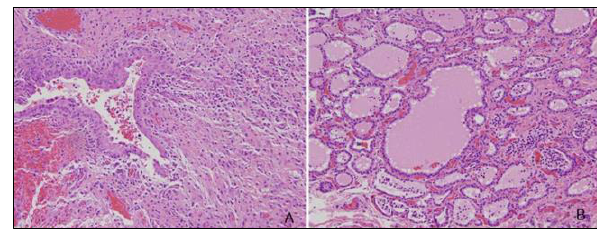
Figure 3: Pathologic findings: A single cuboidal squamous epithelium with partial stratified squamous epithelium and ectopic thymic, thyroid tissue in the wall with chronic in- flammation. (H & E, × 100(A), ×